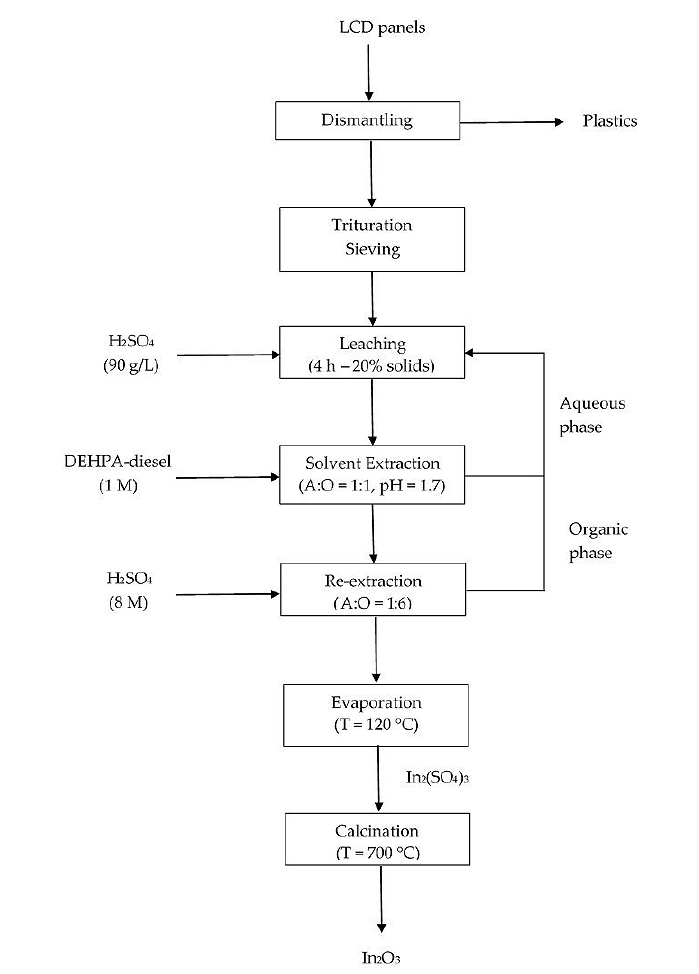
Figure 10. Process flow diagram for indium oxide recovery from LCD